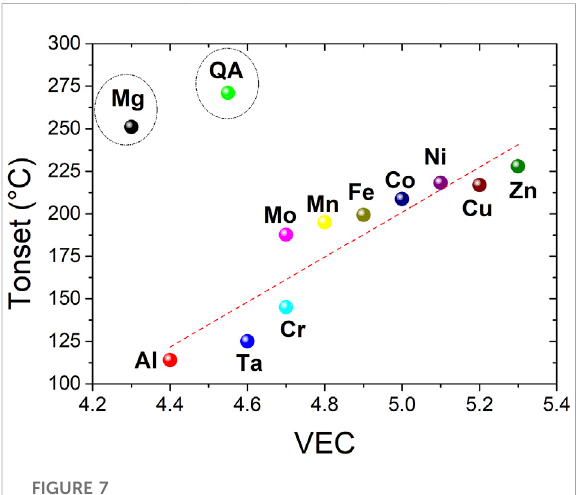
FIGURE 7 The variation of the onset temperature of desorption with VEC for the Ti 0.30 V 0.25 Zr 0.10 Nb 0.25 M 0.10 alloys with M = Mg, Al, Cr, Mn, Fe, Co, Ni, Cu, Zn, Mo, and Ta together with the quaternary material